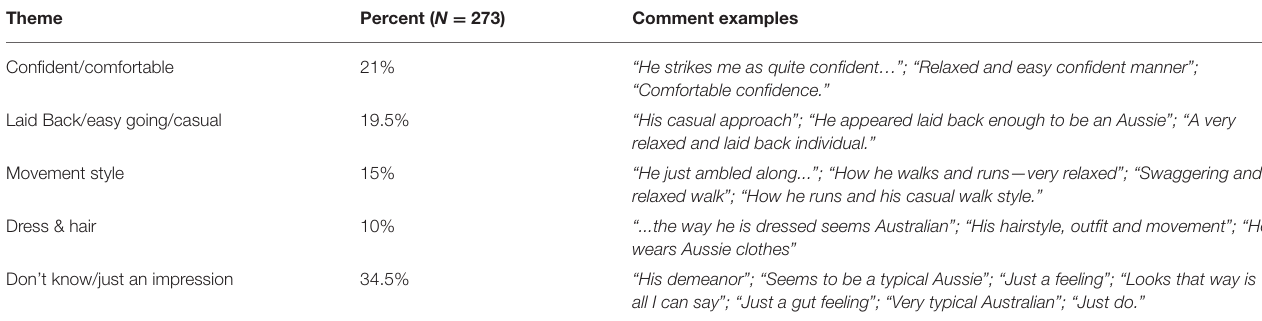
TABLE 2 | Thematic categories, percentages, and examples. Theme Percent ( N = 273) Comment